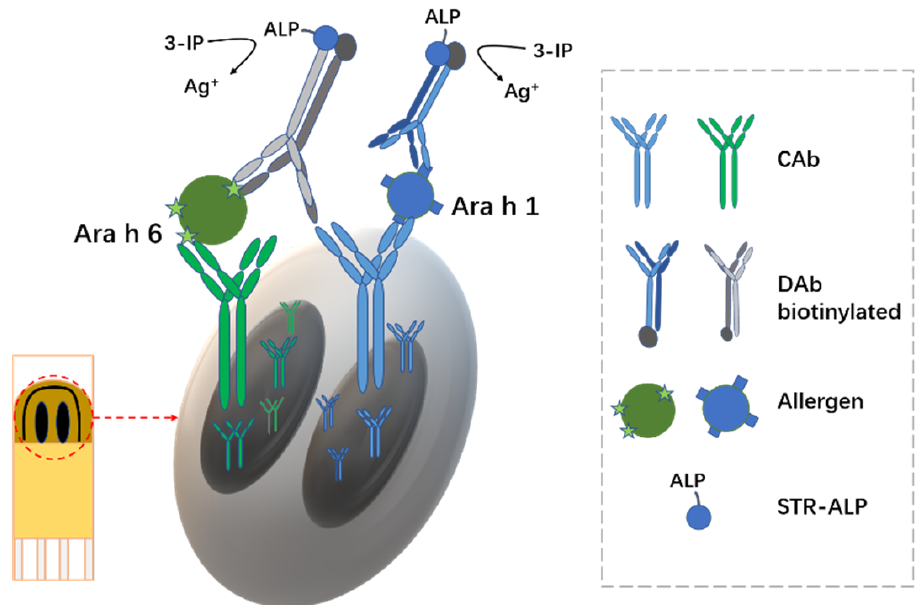
Figure 12. Schematic diagram of the immune sensor configuration and structure (Adapted with permission from Ref. [42]. 2021, Freitas et al.). Table 4. Electrochemical biosensors for soy allergen detection.